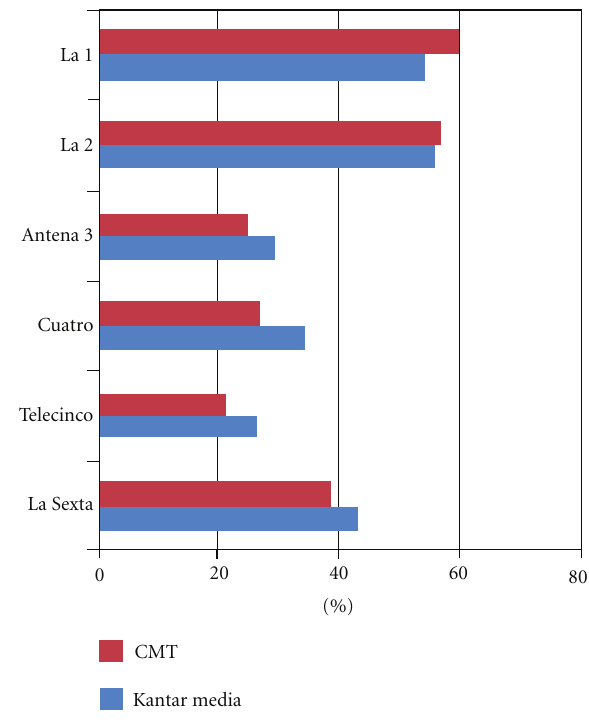
Figure 2: Average percentages of subtitling in the two main DTT channels in Spain during the first semester of 2010. Comparison of sources: CMT and Kantar (elaborated by the